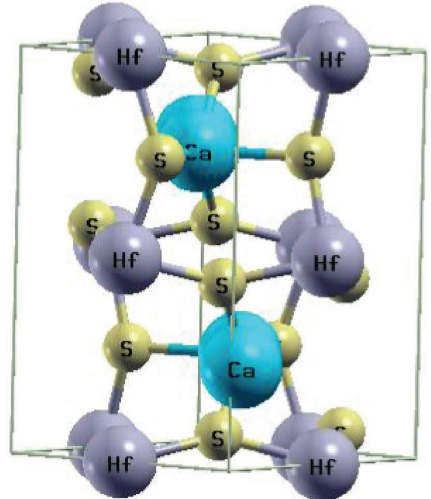
Figure 1: Te GdFeO3-type crystallographic structures of CaHfS